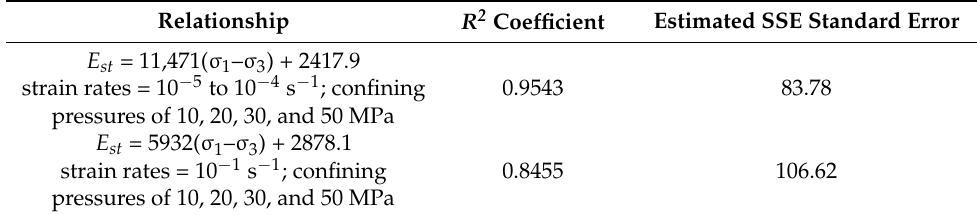
Figure 7. Linear dependence E st = f ( σ 1 – σ 3 ) for various coal strain rates. Table 8. Linear regression analysis results of E st = f ( σ 1 – σ 3